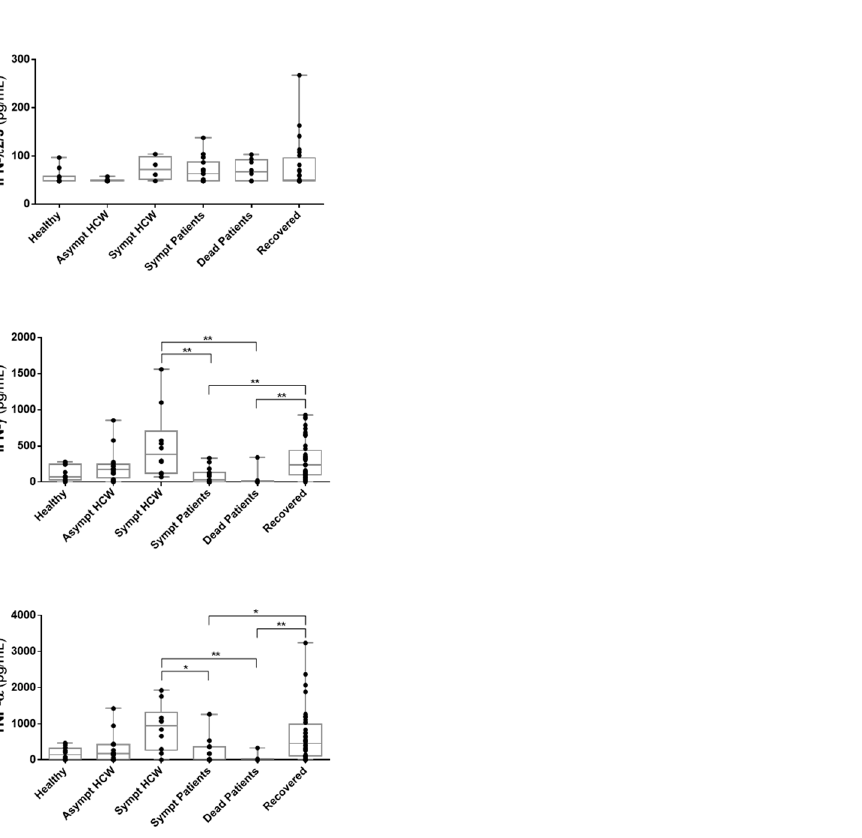
Figure 2. Comparison of IFN- λ 2/3, IFN- γ and TNF- α concentrations in different groups of HCWs and COVID-19 patients who have detectable anti-SARS-CoV-2 antibodies. Plasma samples from non-COVID-19 healthy individuals (n = 11–13), asymptomatic HCWs (n = 8–16), acute symptomatic HCWs (n = 4–10), acute symptomatic COVID-19 patients (n = 15), COVID-19 patients who died (n = 8) and patients recovered from COVID-19 (n = 24–44). ( A ) IFN- λ 2/3; ( B ) IFN- γ ; and ( C ) TNF- α . The box plots show the median (middle line), and the whiskers show minimum to maximum quartiles above and below the box. The p values were calculated using the Kruskal–Wallis test followed by Dunn’s multiple comparisons test. * p < 0.05; ** p < 0.01.